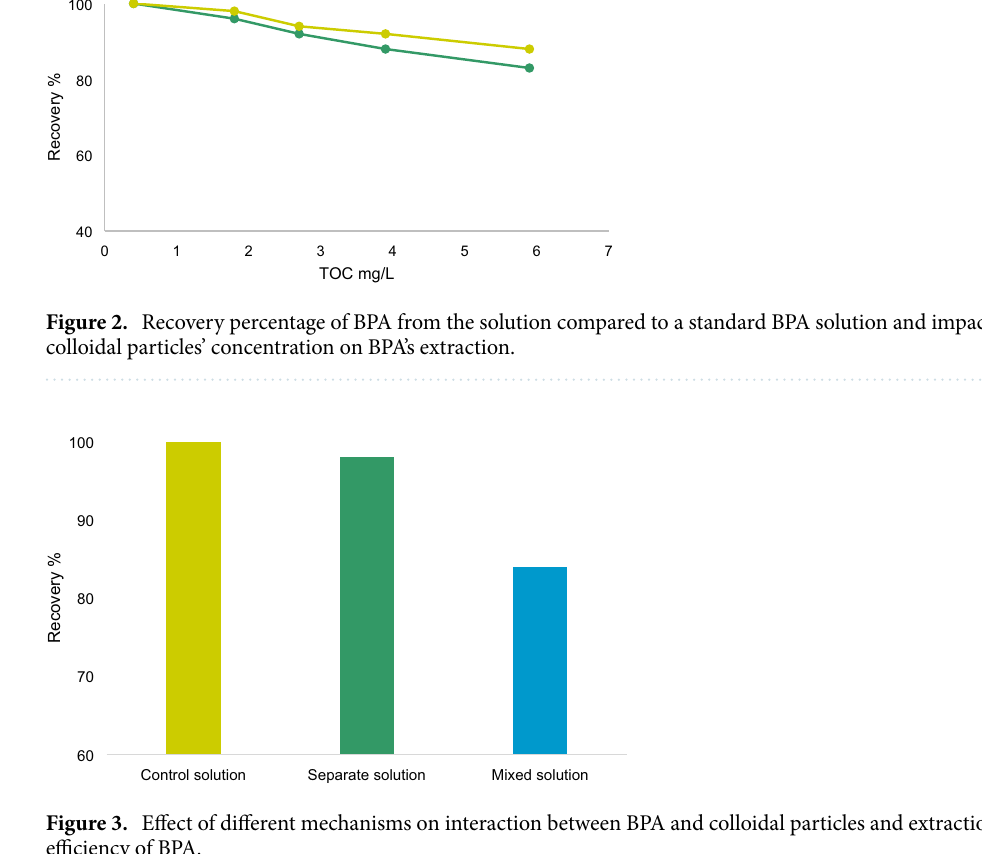
Figure 3. Effect of different mechanisms on interaction between BPA and colloidal particles and extraction efficiency of